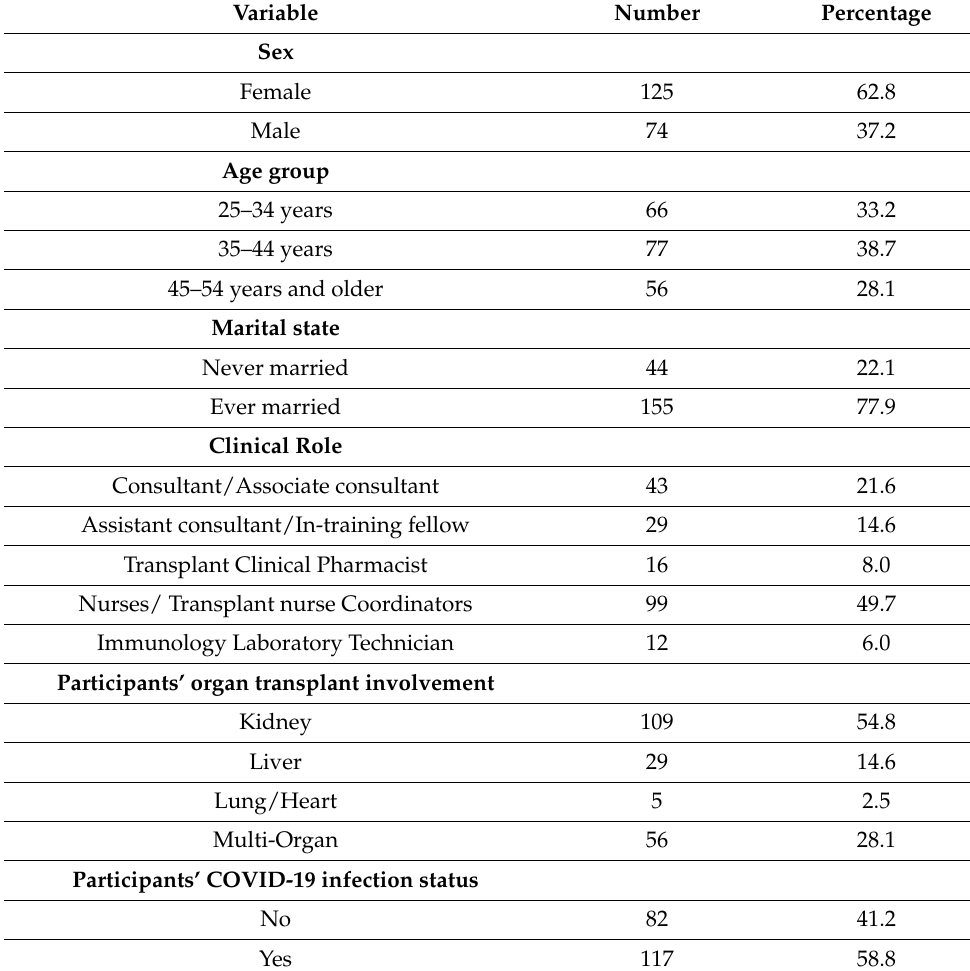
Table 1. Descriptive analysis of the HCW’s sociodemographic (n =